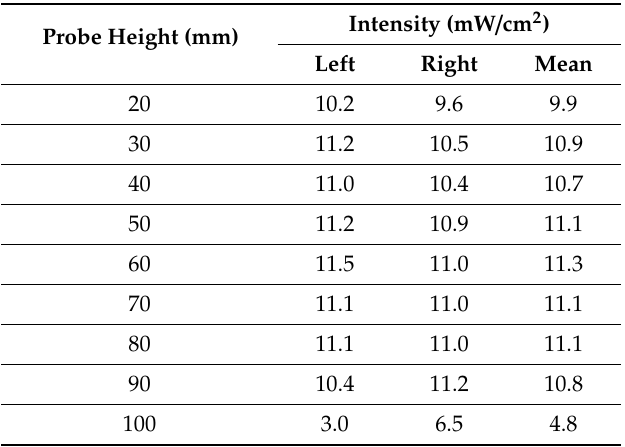
Table 1. The UV intensity, measured using the photodiode, of light transmitted by the left and right side slits as a function of height above the cell